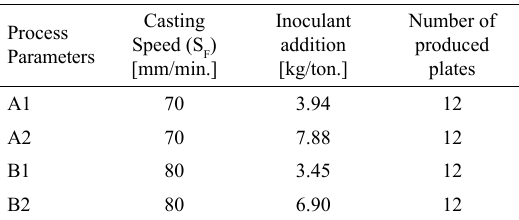
Table 2. Process parameters assessed in this study: final casting speed and inoculant addition. Process